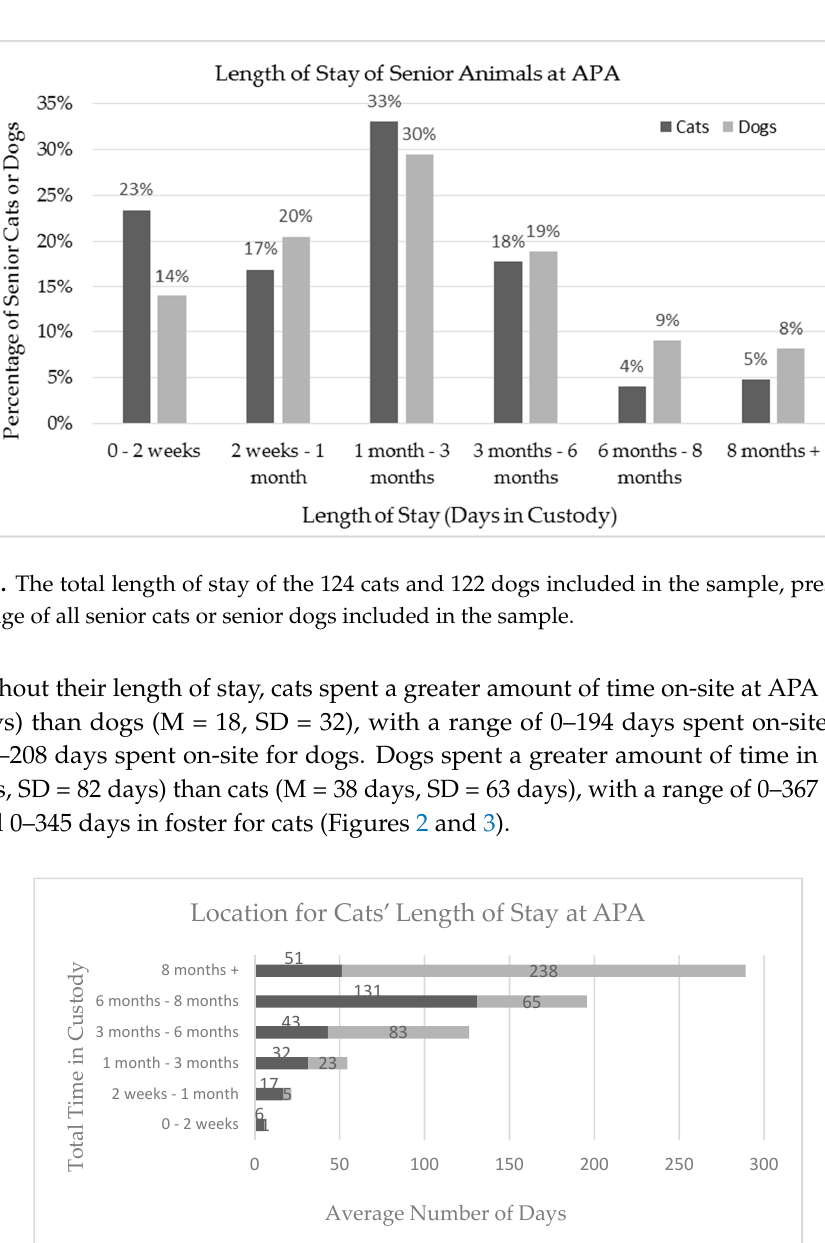
Figure 2. The average time spent in foster care versus on-site at Austin Pets Alive! (APA) for each range of total length of stay (time in custody) for the 124 cats in the sample.